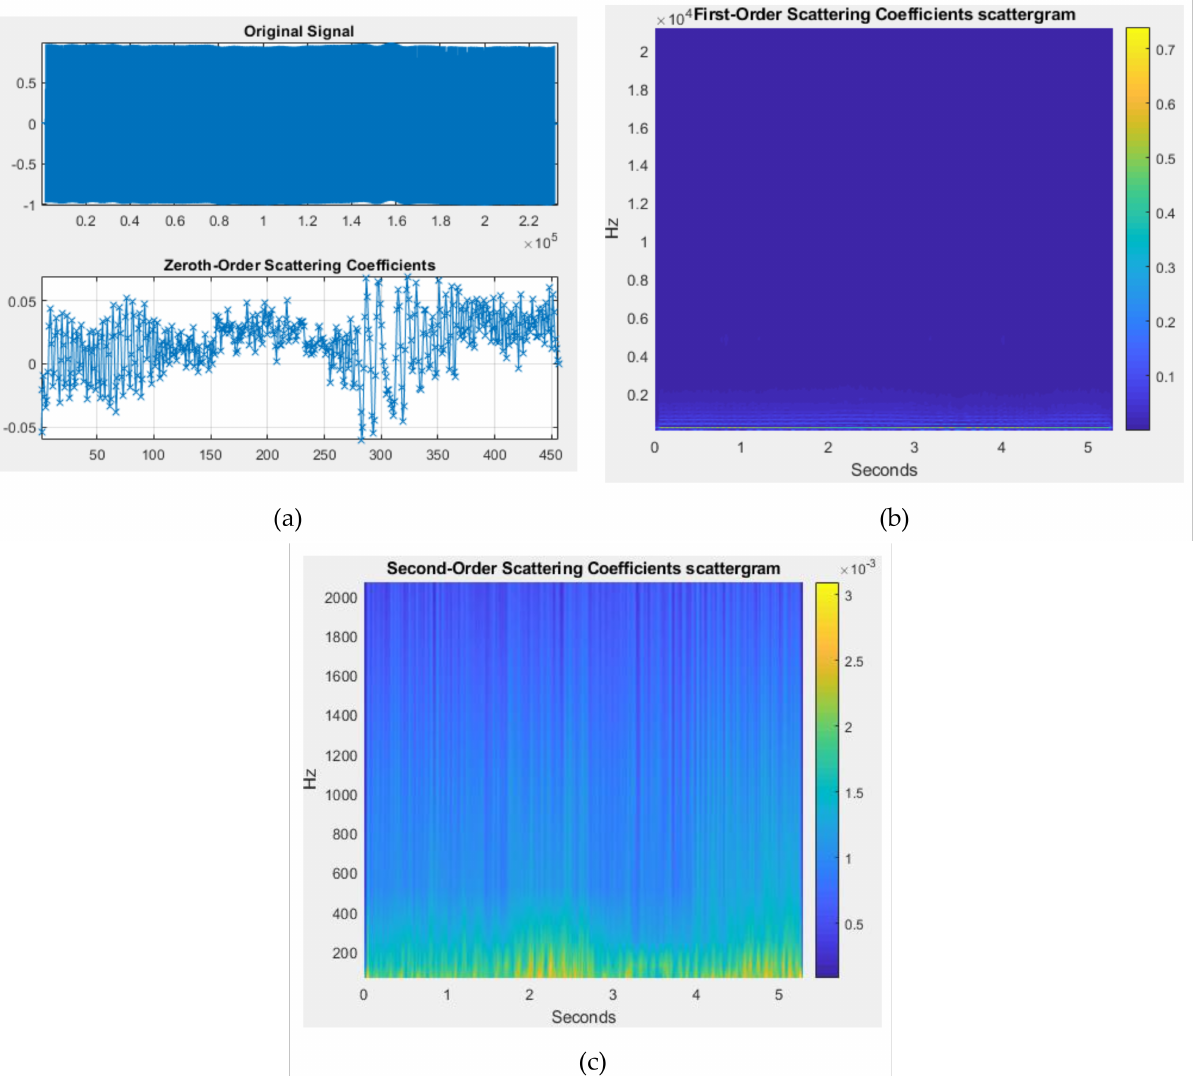
Figure 6. The wavelet scattering features of the non-fault state: ( a ) original signal and zero-order scattering coefficients; ( b ) first-order scattering coefficients scattergram; ( c ) second-order scattering coefficients